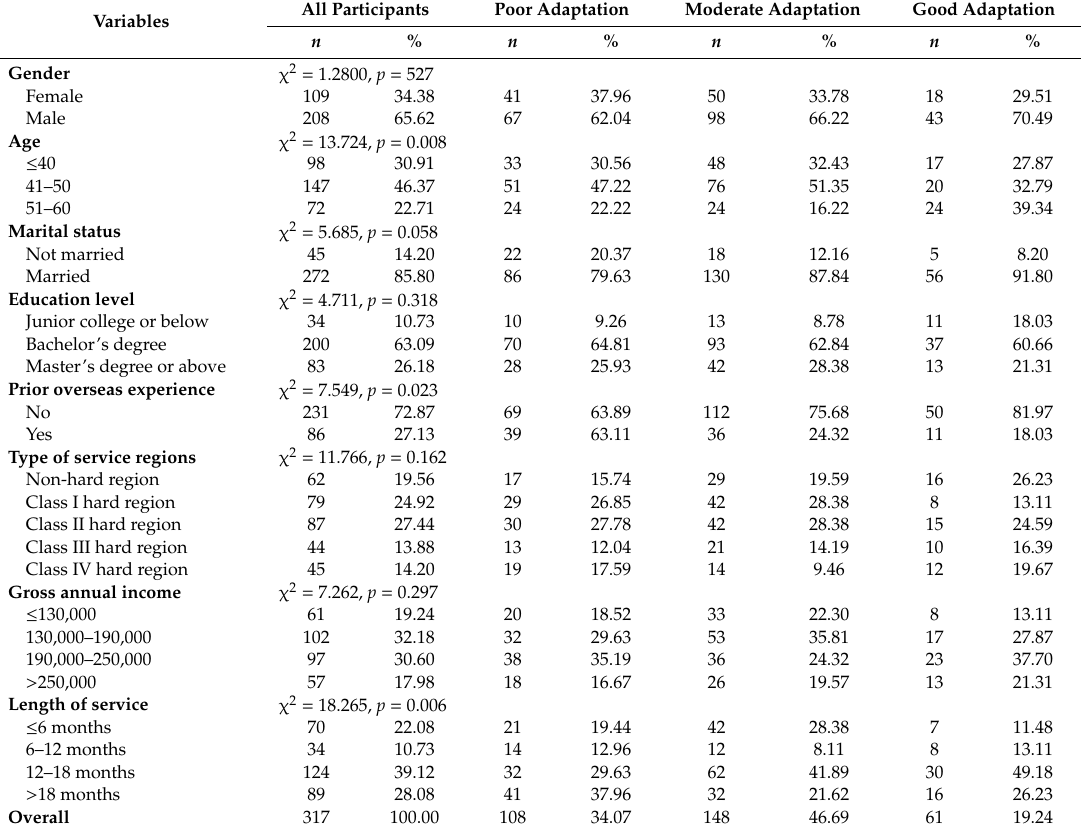
Table 1. Characteristics of the study population by level of cross-cultural adaptation ( n = 317).